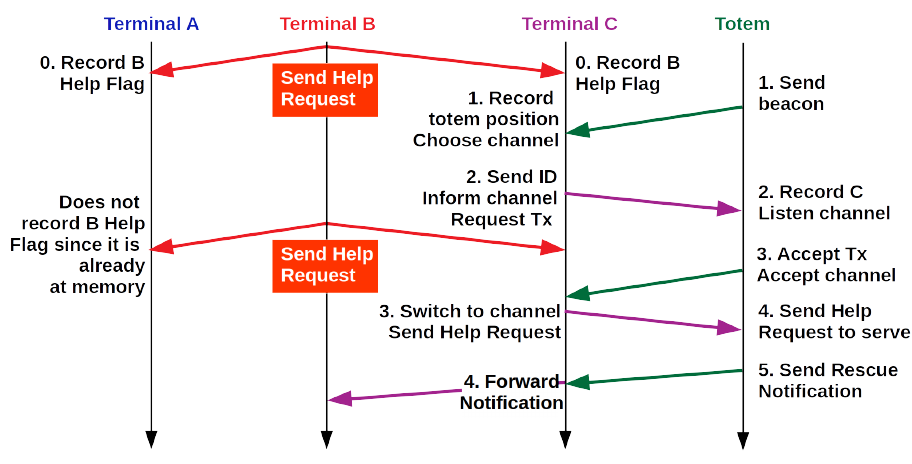
Figure 12. Communication in an emergency